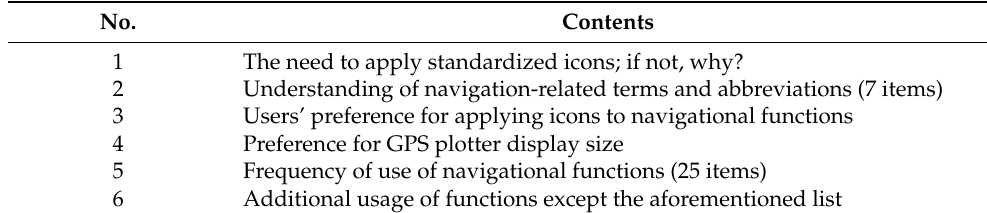
Table 2. Items of user survey on GPS plotter.